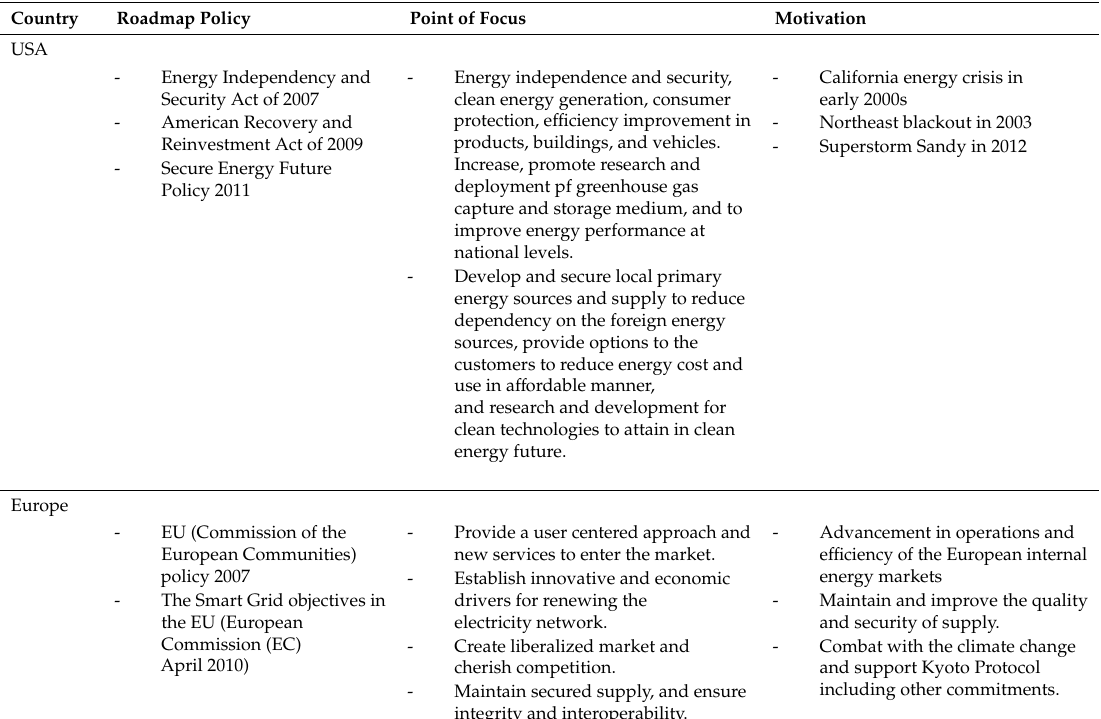
Table 3. Comparative illustrations on smart grid roadmap policies, point of focus, and motivation for di ff erent countries